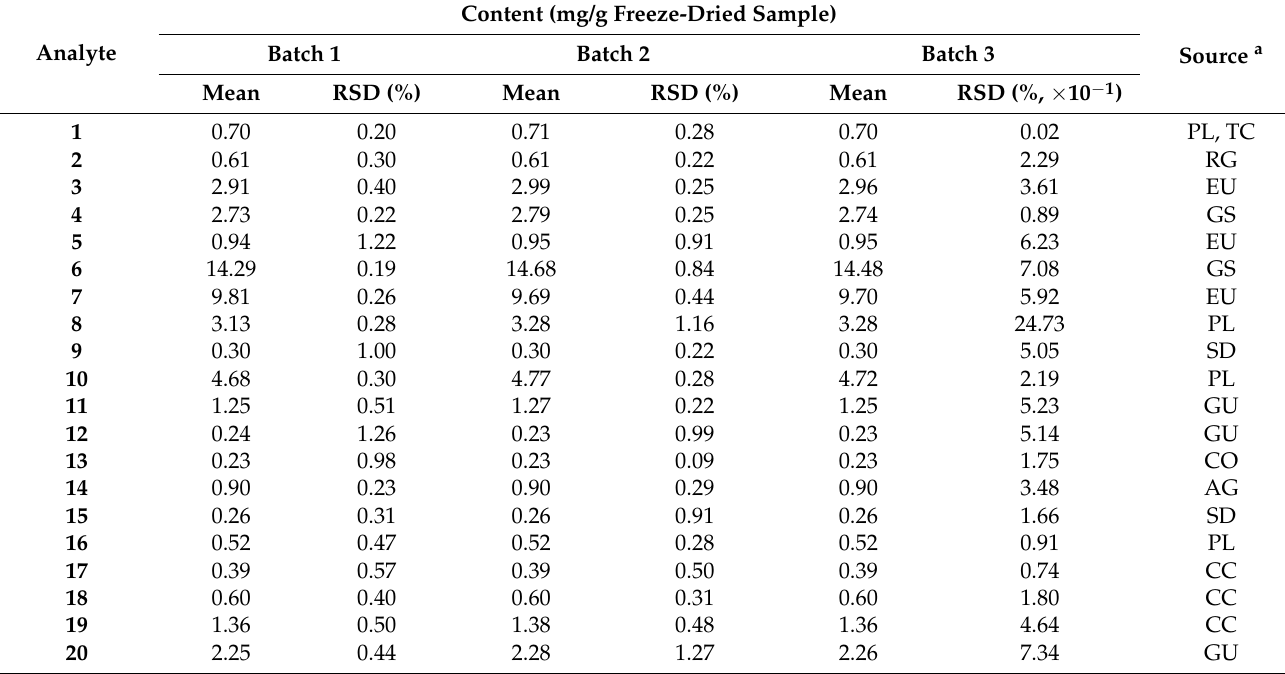
Table 4. Content of the 24 marker analytes in the DHGST sample determined using HPLC ( n =